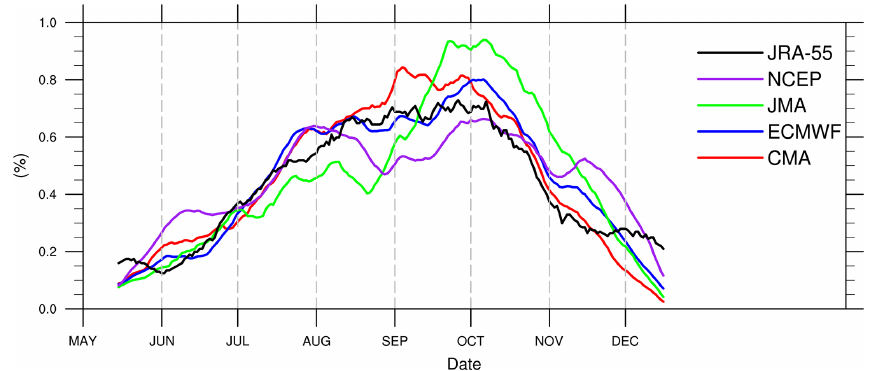
Figure 5. Climatological daily number distribution of TC first detection for the TPEPS TC event set (CMA: red, ECMWF: blue, JMA: green, NCEP: purple) and the JRA-55 event set (black), i.e. the probability of TCs being first detected at a given day in the model. The 30d moving average is used in order to remove high-frequency signals.